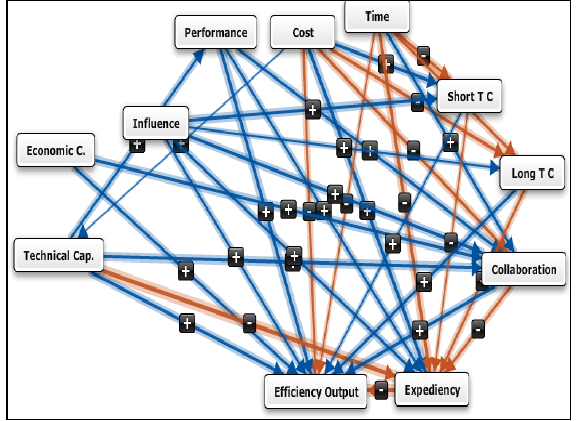
Figure 4: Cognition Model of Inter-relationship of parameters A fuzzy set is defined by a value that varies between 0 (lowest or false) and 1 (highest or true), which assigns the membership function to each element in the set (Wang et all ). The shape of